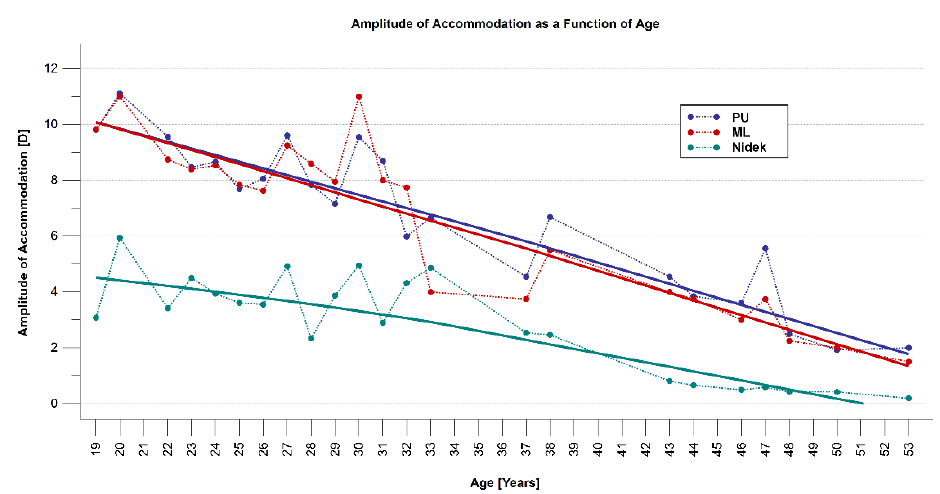
Figure 6. Scatter plot showing the amplitude of accommodation (AA) obtained with all the three methods: subjective push-up (PU), subjective minus-lens (ML), and objective Nidek methods as a function of age.